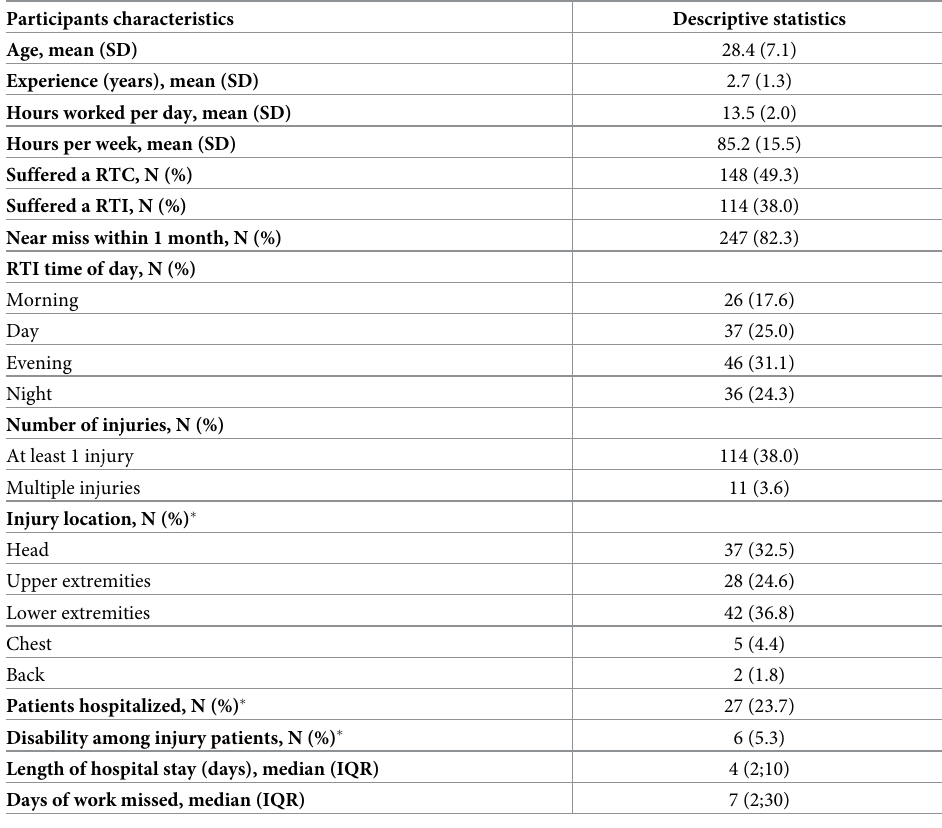
Table 1. Characteristics of boda boda